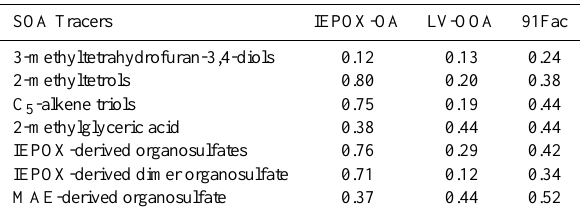
Table 2. Correlation ( r 2 ) of PMF factors with isoprene-derived SOA tracers measured by GC/EI-MS and UPLC/DAD-ESI-HR- QTOFMS.